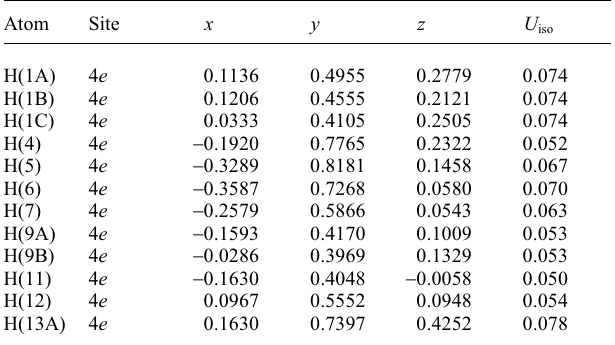
Table 2. Atomic coordinates and displacement parameters (in Å 2 ) .